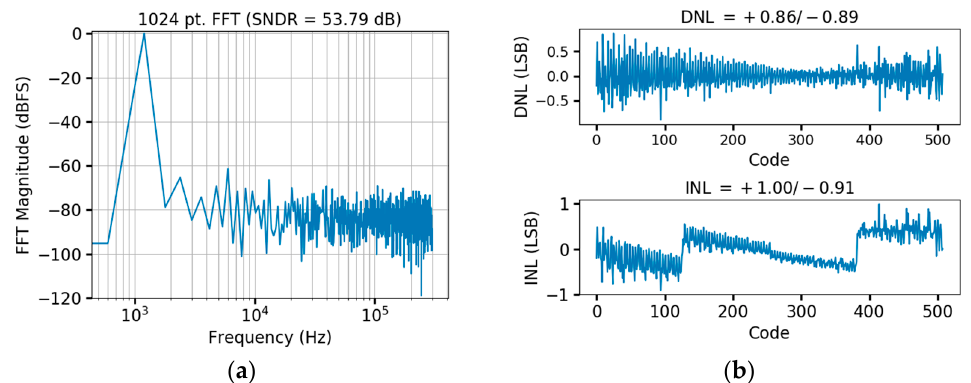
Figure 12. ADC test results. ( a ) FFT with 1 kHz input sinusoid showing 53.8 dB SNDR; ( b ) Linearity measurements showing DNL of +0.86/ − 0.89 and INL of +1.00/ − 0.91.